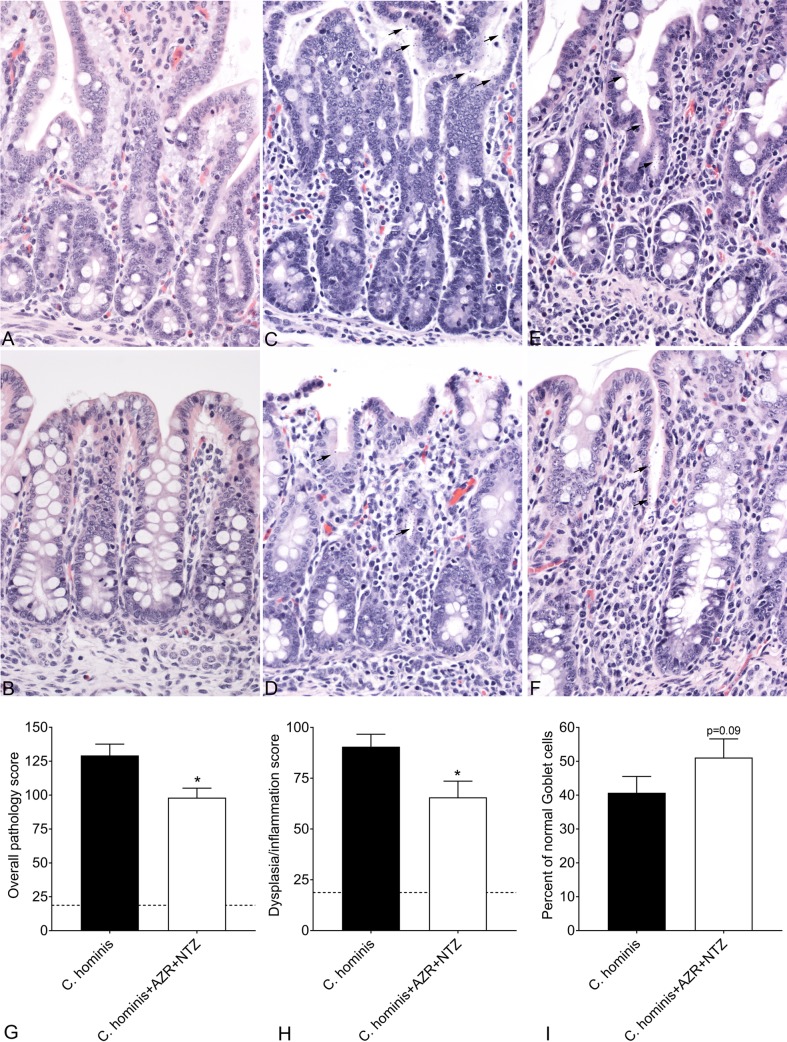
Microscopic lesions of C. hominis infection.Photomicrographs are from ileum and large intestine, stained with hematoxylin and eosin, magnified 400 times normal. Normal small and large intestine are shown in A and B, respectively. Small and large intestine from C. hominis are shown in C and D, respectively with moderate epithelial dysplasia, moderate loss of Goblet cells, moderate lymphocytic inflammation, and C. hominis organisms (black arrows). Small and large intestine from C. hominis treated with ARZ+NTZ are shown in E and F, respectively with mild epithelial dysplasia, mild loss of Goblet cells, and C. hominis organisms (black arrows). The overall pathology score is shown in G, with component scores for dysplasia/inflammation and Goblet cells shown in H and I, analyzed by the Mann-Whitney t-test with p<0.05. Dashed lines indicate the average score for uninfected piglets.